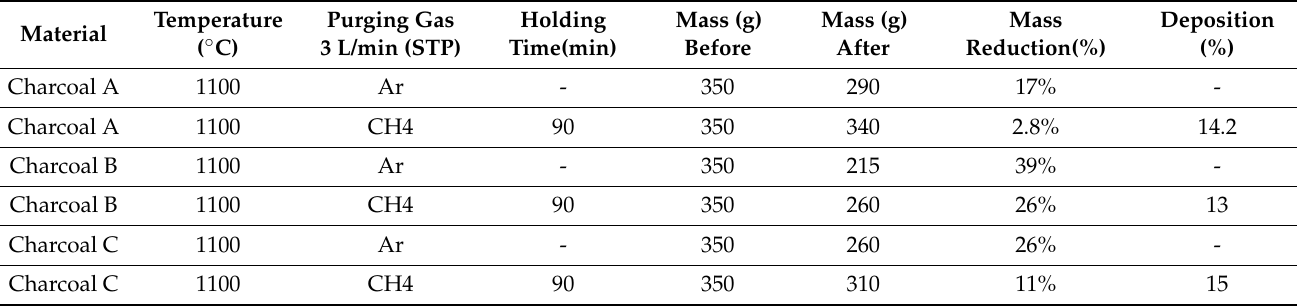
Table 1. Overview of conducted